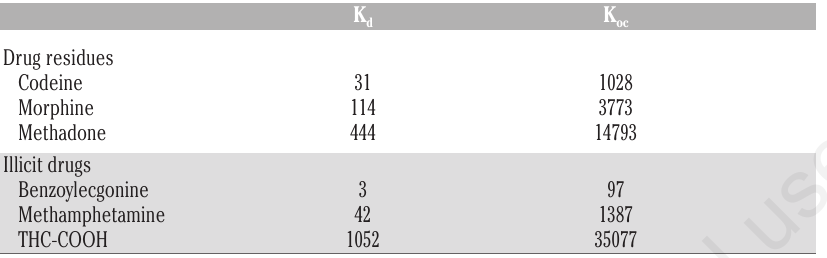
Table 2. Affinity of illicit drugs and drugs residues onto sediments estimated from distri- bution coefficient and carbon-normalized distribution